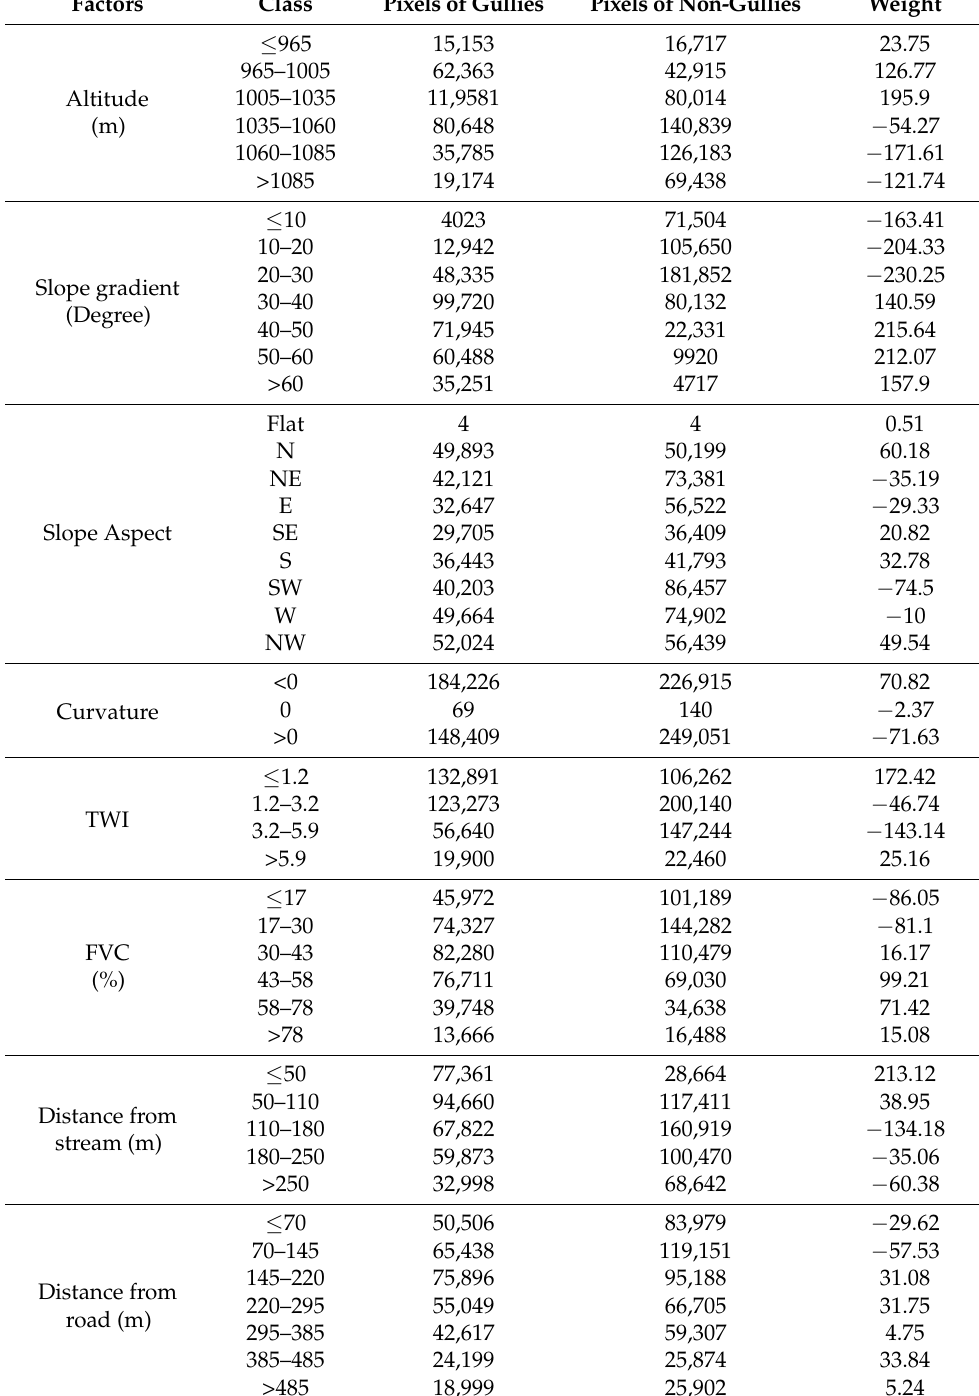
Table 2. The relative importance of conditioning factor classes to gully erosion locations using the weights-of-evidence (WoE)